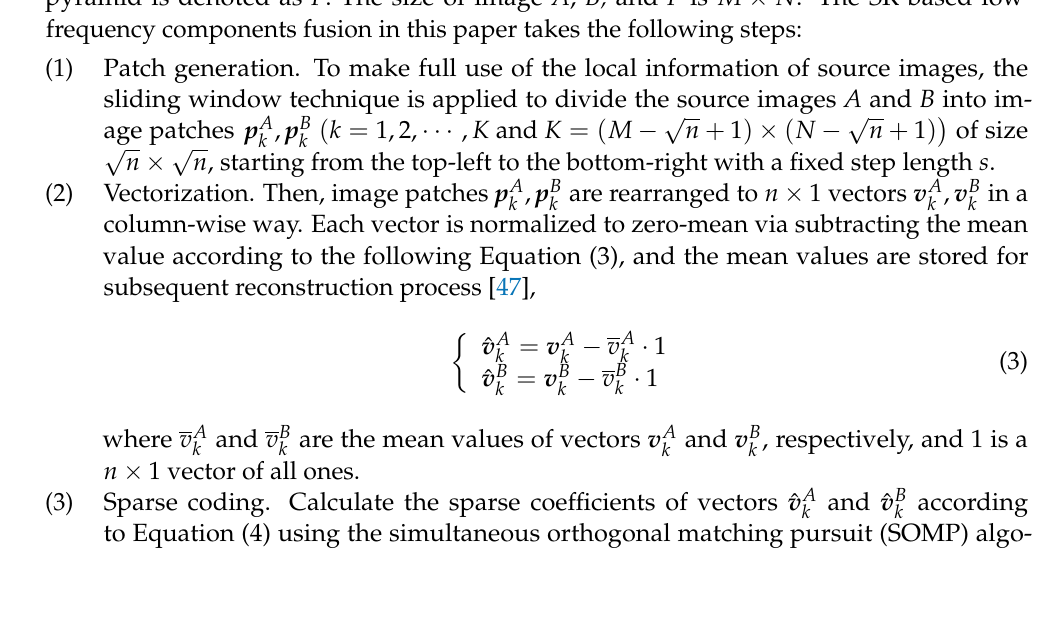
M S L of MS image Laplacian pyra- N of SAR image Laplacian S A R L of SAR image Laplacian pyra- N F L of fusion image Lapla- N . The SR-based low-